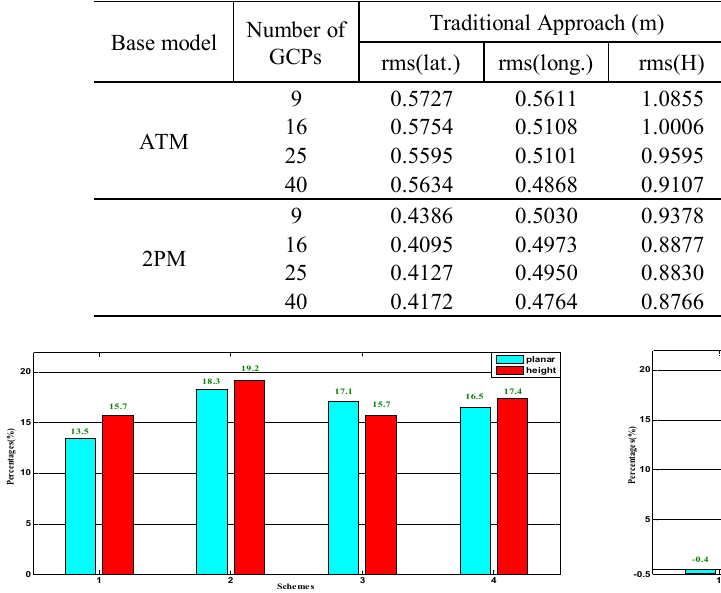
Table 1. RMS of traditional approach and LSC approach for ATM and 2PM